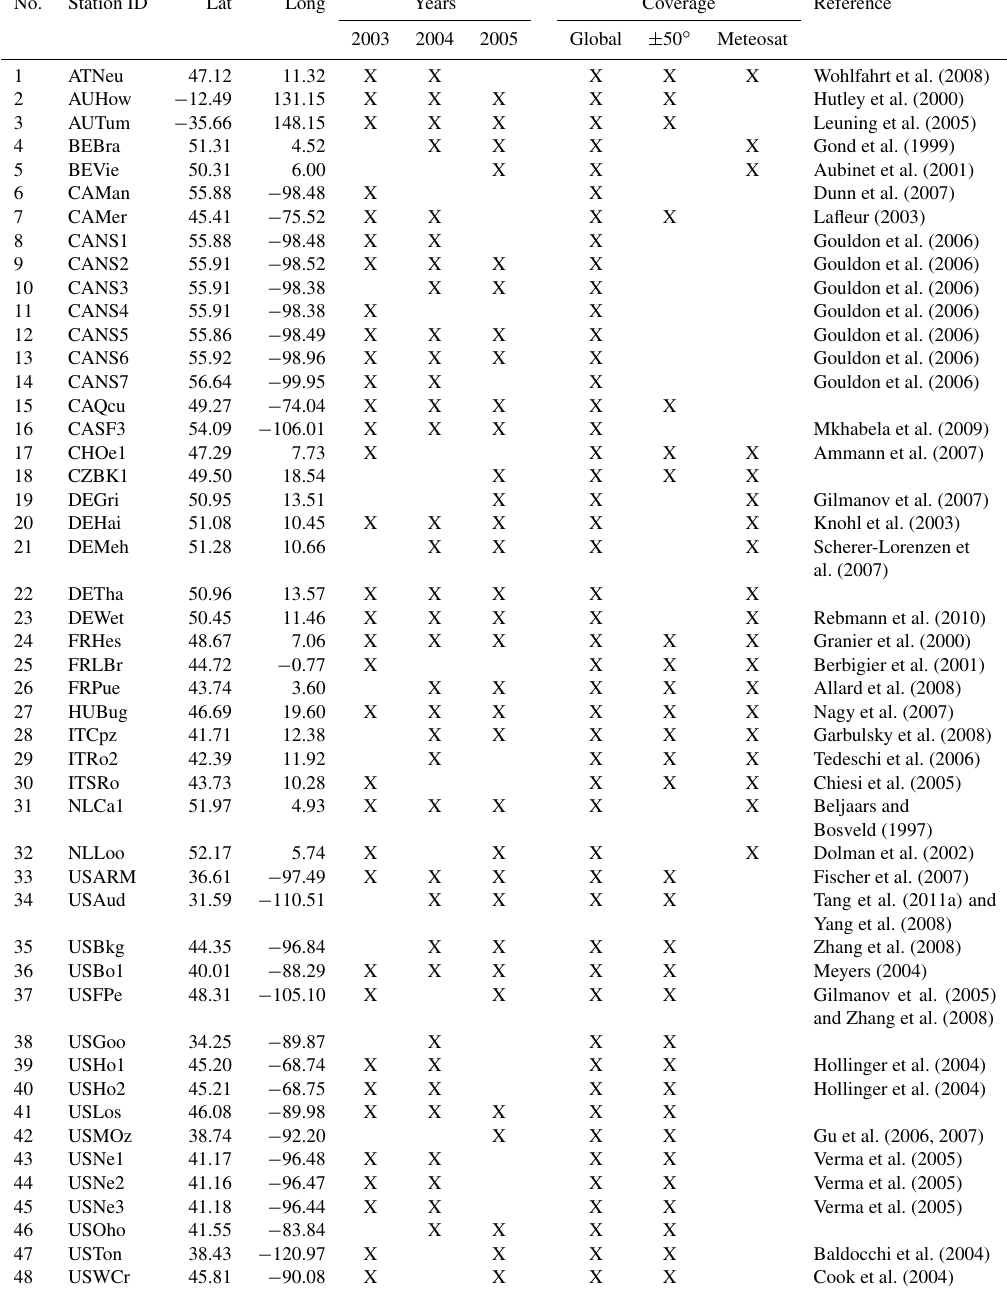
Table C1. List of FLUXNET stations investigated. The coverage term specifies the location of each FLUXNET station. ± 50 ◦ refers to the station being within the latitudes 50 ◦ N, 50 ◦ S, while Meteosat indicates the station is within the coverage of Meteosat. For details on the spatial coverage see Fig.